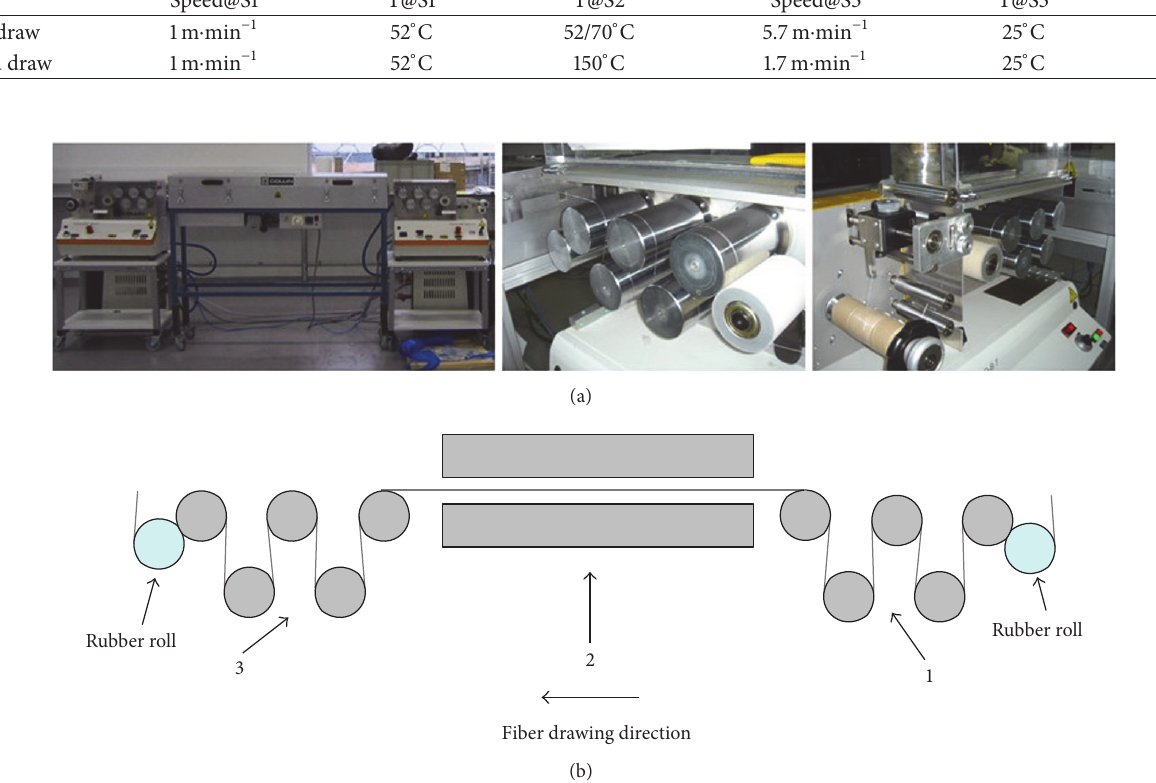
Figure 2: (a) Photographs of the monofilament drawing line, from left to right: complete drawing line; close view of holding back godet rolls (Section 1 ); and close view of take-off godet rolls (Section 3 ); (b) schematic of monofilament drawing line: Section 1 , temperature controlled holding back godets; Section 2 , hot air oven; Section 3 , temperature controlled take-off godets plus